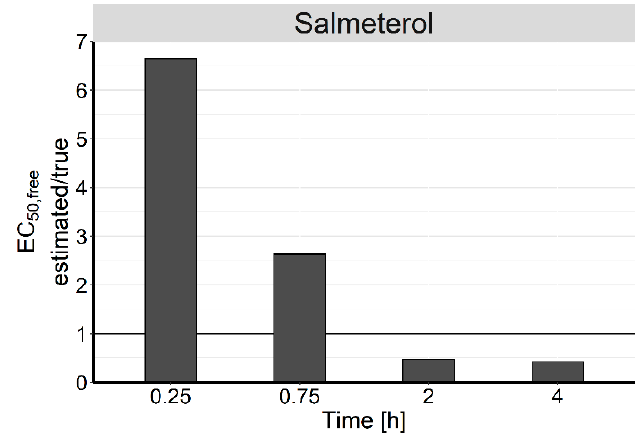
Figure 6. Plasma EC 50,free estimates of salmeterol normalized to the true EC 50 value, determined at four different time points. Unbound bronchial tissue concentrations were assumed to be directly correlated to the effect.